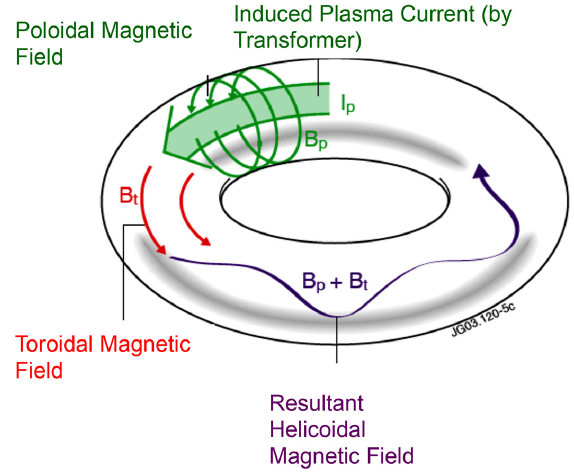
Fig. 7. – Principle of the tokamak: A large current induced in the plasma ring generates a poloidal magnetic field. The combination of this poloidal field with the main toroidal field results in a helical magnetic field, necessary for a stable confinement of the plasma in a toroidal